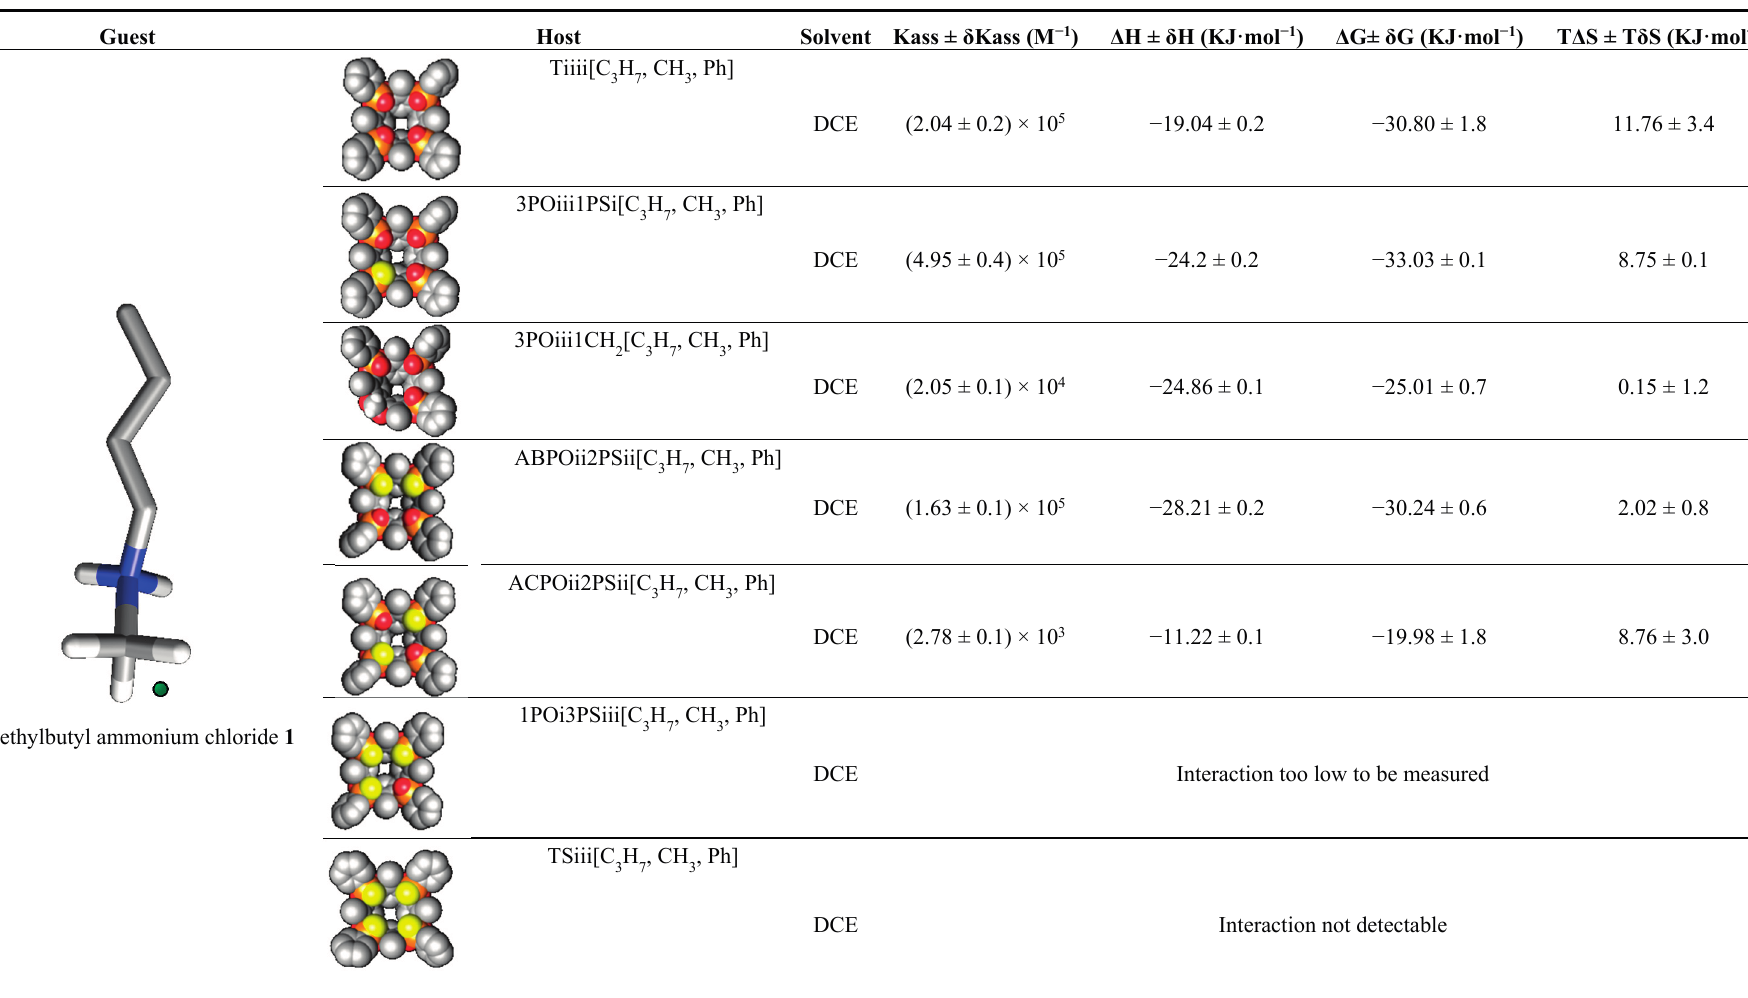
H , CH , Ph] , 3POiii1CH 3 7 3